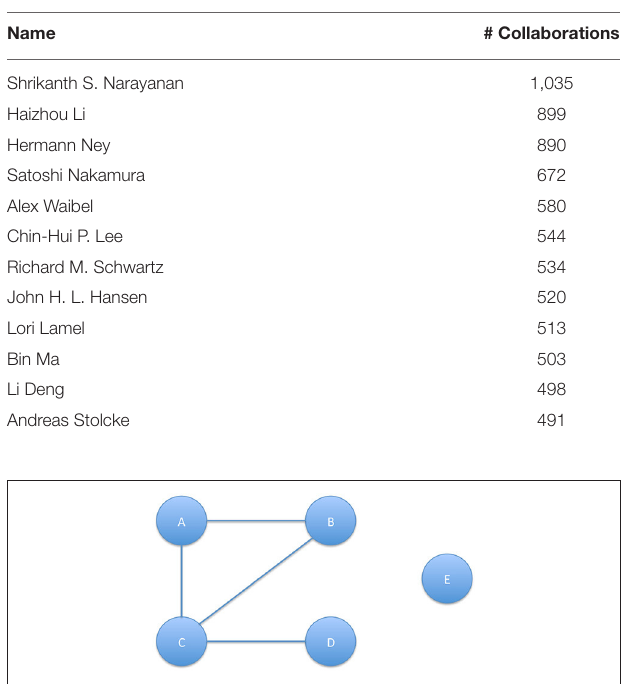
TABLE 6 | The 12 authors with the largest number of collaborations.